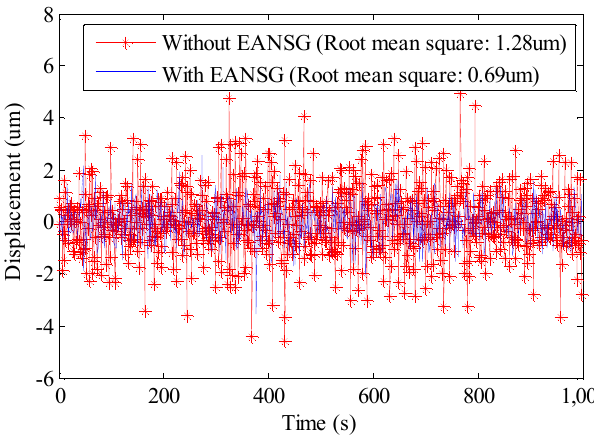
Figure 19. Experimental results of displacement.